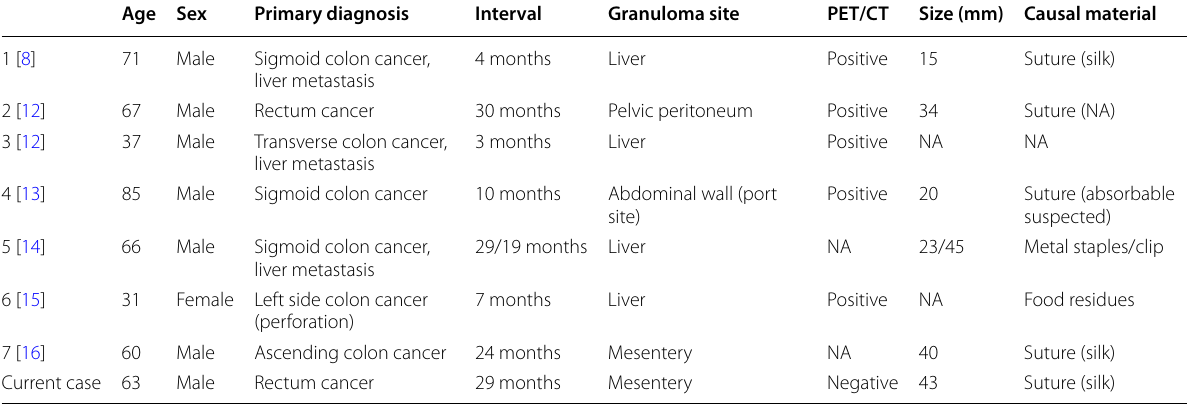
Table 1 Cases of granuloma in patients who underwent colorectal cancer